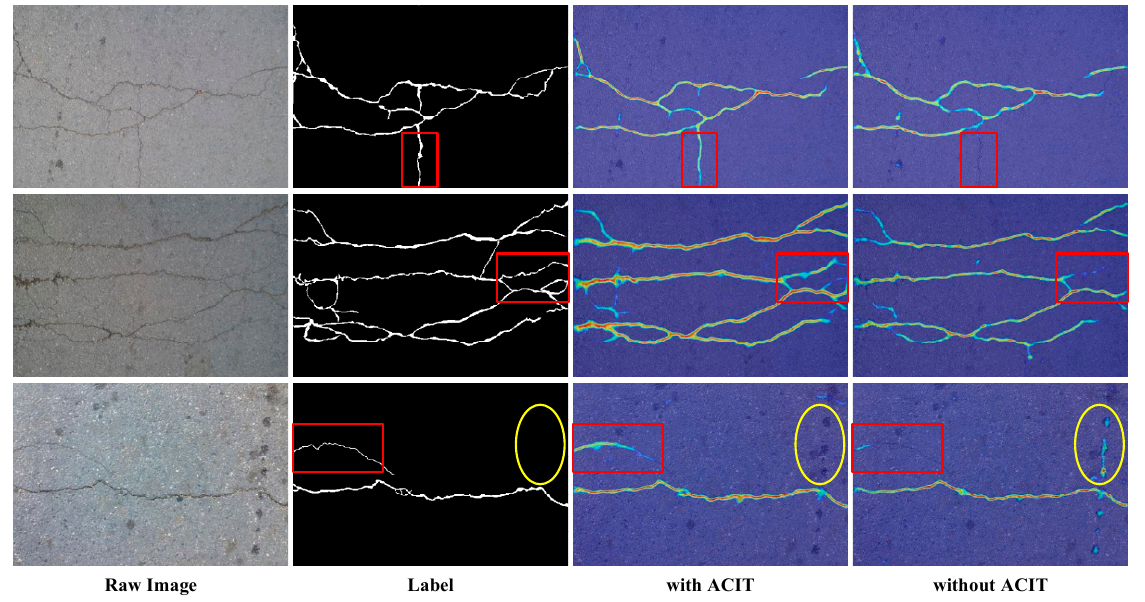
Figure 6. The visualization of feature heat maps during training with/without the proposed ACIT module. With the use of the ACIT module, the model pays more attention to tiny crack regions (red rectangular boxes) and simultaneously reduces the interference of noises (yellow ellipses).